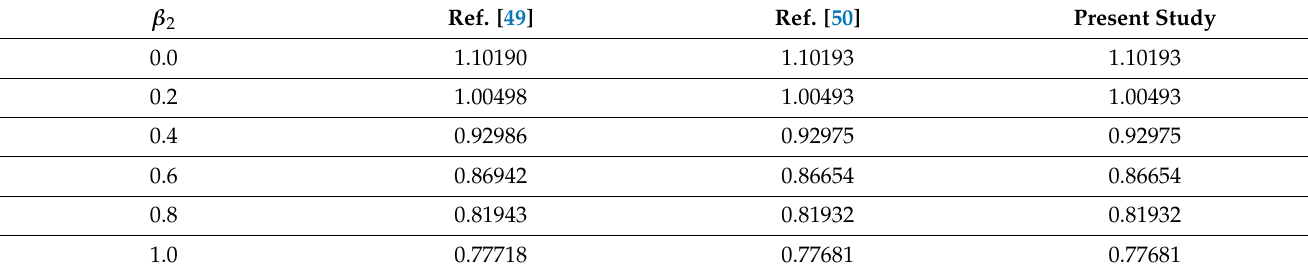
Table 3. Comparison of the results of f (cid:48)(cid:48) ( 0 ) for β 2 when A = δ = 0 with fixed β 1 =